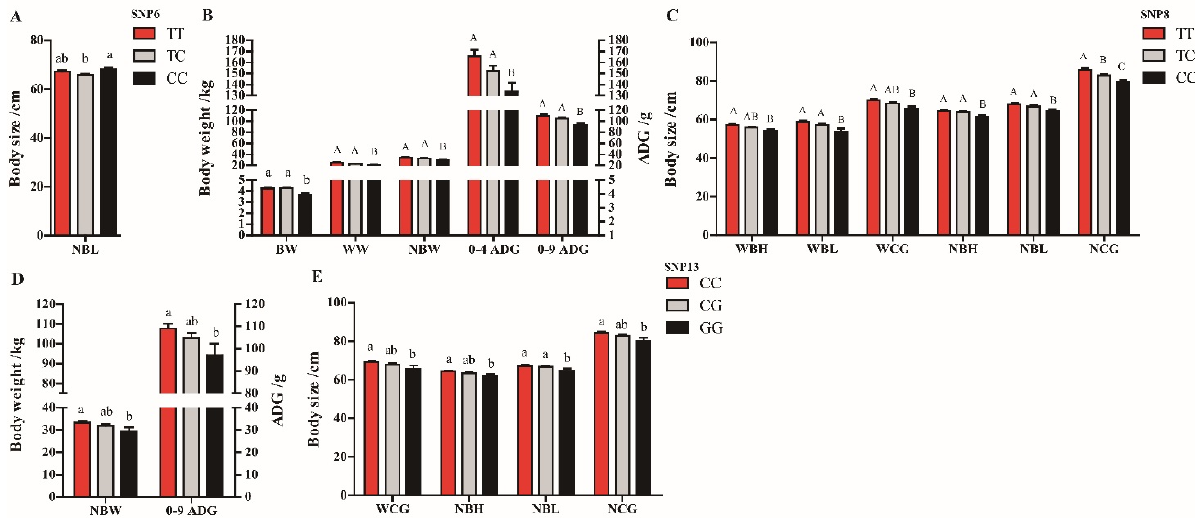
Figure 4. Associations for the SNPs of IGF1R gene with growth traits in Hulun Buir sheep. ( A ) Association analysis for different genotypes of SNP6 in the IGF1R gene with growth traits; NBL = body length at 9-months-old. ( B ) The comparison of body weight traits in SNP8 genotypes of IGF1R gene; BW = birth weight; WW = weaning weight (4-month-old); NBW = body weight at 9-months-old; 0–4 ADG = average daily gain from birth to 4-months-old; 0–9 ADG = average daily gain from birth to 9-months-old. ( C ) Association analyses for different genotypes of SNP8 in IGF1R with body size traits; WBH = body height at 4-months-old; WBL = body length at 4-months-old; WCG = chest girth at weaning (4-months-old); NBH = body height at 9-months-old; NBL = body length at 9-months-old; NCG = chest girth at 9-months-old. ( D ) The comparison of body weight traits in SNP13 genotypes of IGF1R gene; NBW = body weight at 9-months-old; 0–9 ADG = average daily gain from birth to 9-months-old. ( E ) Association analyses for different genotypes of SNP13 in the IGF1R with body size traits; WCG = chest girth at weaning (4-month-old); NBH = body height at 9-months-old; NBL = body length at 9-months-old; NCG = chest girth at 9-months-old. Different letters (small letters: p < 0.05; capital letters: p < 0.01) above the column indicate significant differences among the different genotypes.